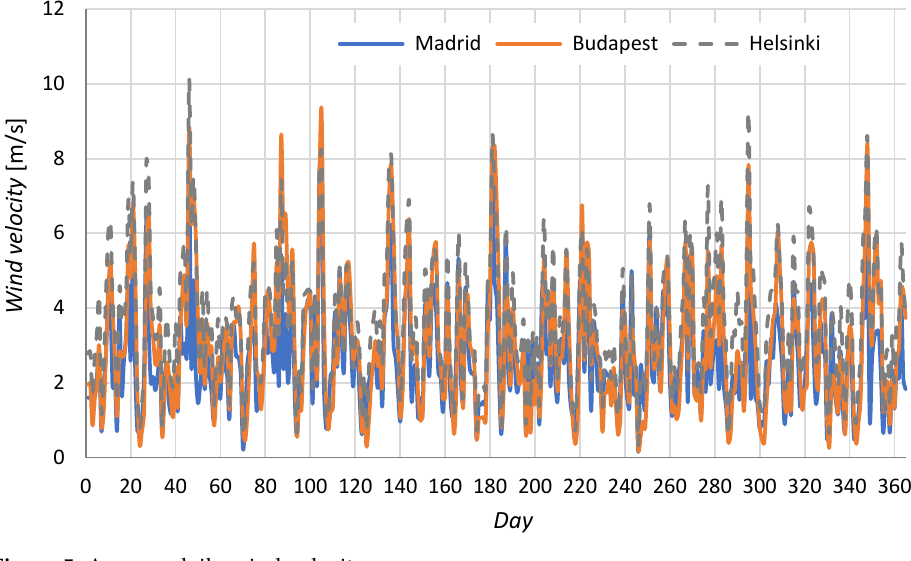
Figure 5. Average daily wind velocity.